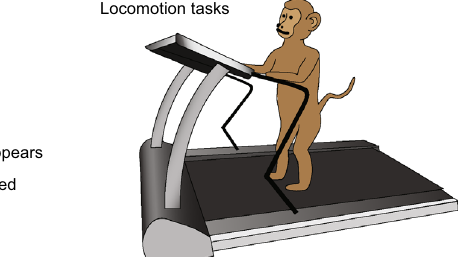
Figure 1. (1) Centerout tasks: monkeys were seated in front of a video screen and grasped the handle of a planar manipulandum that controlled the position of a cursor. Monkeys made reaching movements to a sequence of targets appearing on the screen while we recorded neural activity in primary motor cortex using an implanted electrode array. (2) Locomotion tasks: monkeys walked on the treadmill. We measured the ankle x and ankle y while we recorded neural activity in primary motor cortex. We acknowledge artist MinJun Xu for creating the